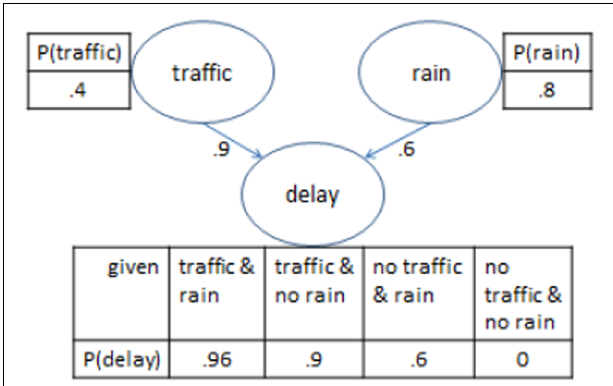
FIGURE 1 | Illustration of the components of a Bayesian network. See main text for